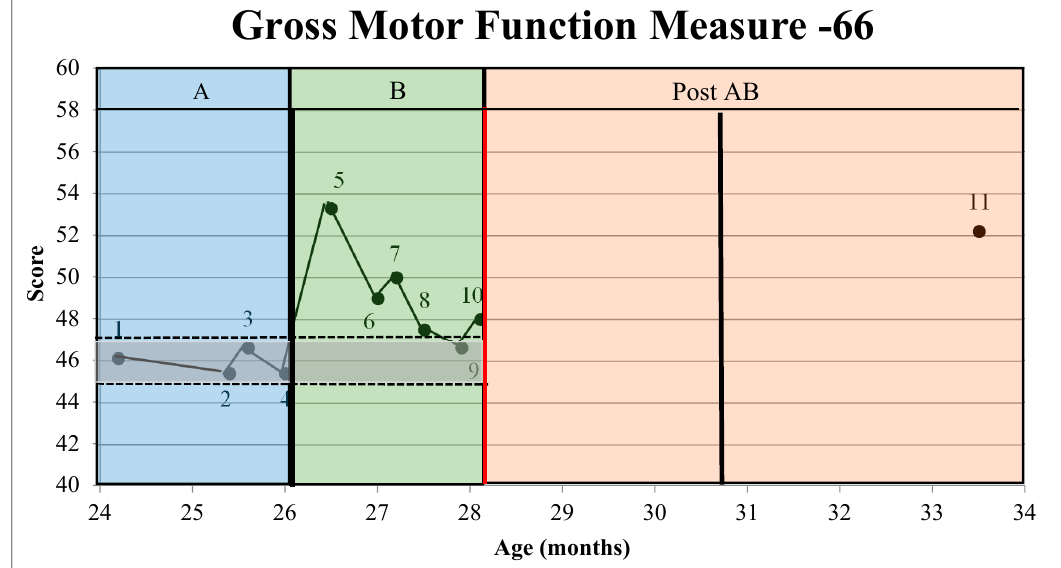
Figure 3. Gross Motor Function Measure Across the AB +1 Phases. Scores of the Gross Motor Function Measure (GMFM-66) across the AB +1 phases as plotted in reference to the +/ − 2 standard deviation band (shaded in grey). A = baseline data collection with no intervention, B = Botulinum toxin A/phenol and START-Play physical therapy intervention provided for 12 sessions, Post AB = one data point collected via telemedicine (+1) due to Covid-19 restrictions. Points 1–11 denote GMFM-66 testing points. Bolded, black, vertical lines denote Botulinum toxin-A/phenol injections. The bolded, red vertical line denotes treatment ending due to the Covid-19 pandemic.